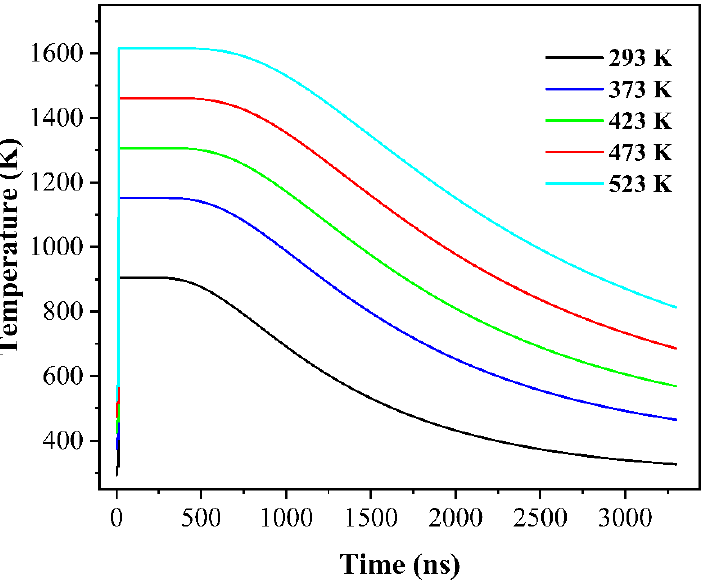
Figure 8. Temperature rise of the defect after laser irradiation under different in situ temperatures.